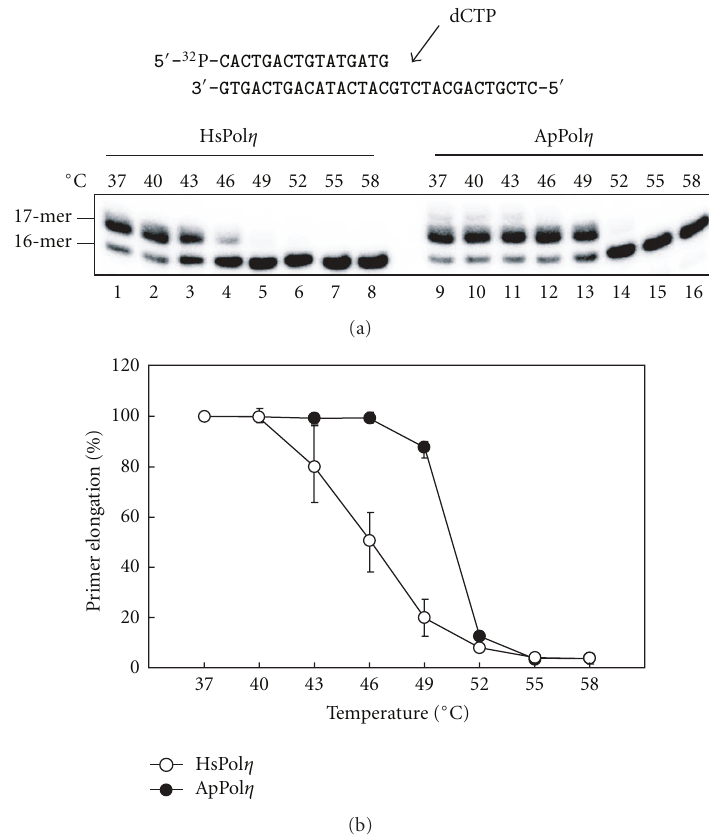
Figure 7: Thermostability of ApPol η . (a) Aliquots of ApPol η (closed circles) and HsPol η (open circles) were heated to the indicated temperature for 5 minutes. The e ff ect of this treatment on the polymerase activity was subsequently determined by analyzing the respective enzyme’s ability to extend a radiolabeled primer by incorporating dCMP opposite the template G. Replication assays were performed at 37 ◦ C for 20 minutes. (b) The ability of each enzyme to extend the primer was quantified, and the specific activity compared to that of each enzyme heated at 37 ◦ C was calculated and subsequently plotted as a function of the temperature to which the enzyme was initially